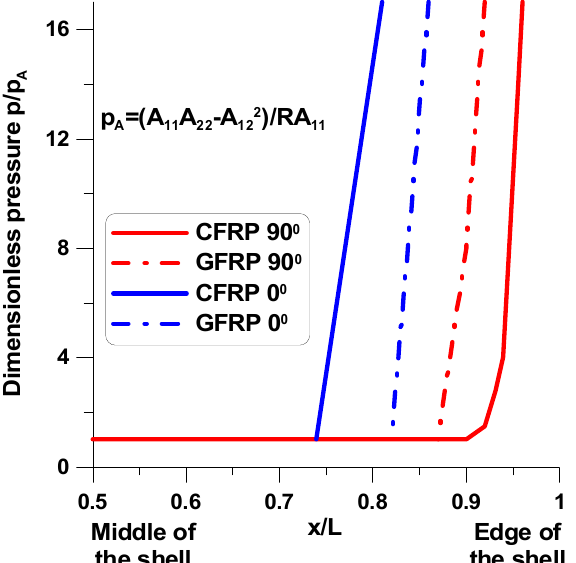
Figure 5. Variations of the contact pressures for angle-ply symmetric laminates—L/R = 2. Damage of structures made of FG materials is studied numerically—see, e.g., [41]. The material gradation results in the difficulty in analyzing failure modes and criteria. The com- position of the constituents varies with physical dimension. Figure 6 represents the change of the multiplier M = —Equation (12) for different location of constituents and the power index n. It is assumed that the analyzed FG material is composed of the metal Ti (E = 100 [GPa]) and the ceramic TiB (E = 300 [GPa]). The composite material is unsymmetric since B rs terms Equation (4) are not equal to zero.